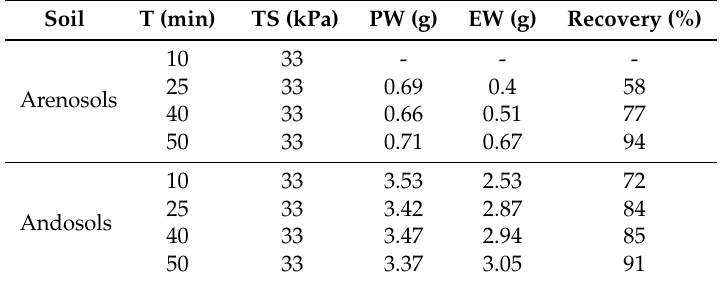
Table 3. Summary of results for experiment A, including time of extraction (T), water tension of the soil sample TS, pore water before extraction, PW, extracted water EW, and percentage of recovery as the ratio of PW to EW. Soil T (min) TS (kPa) PW